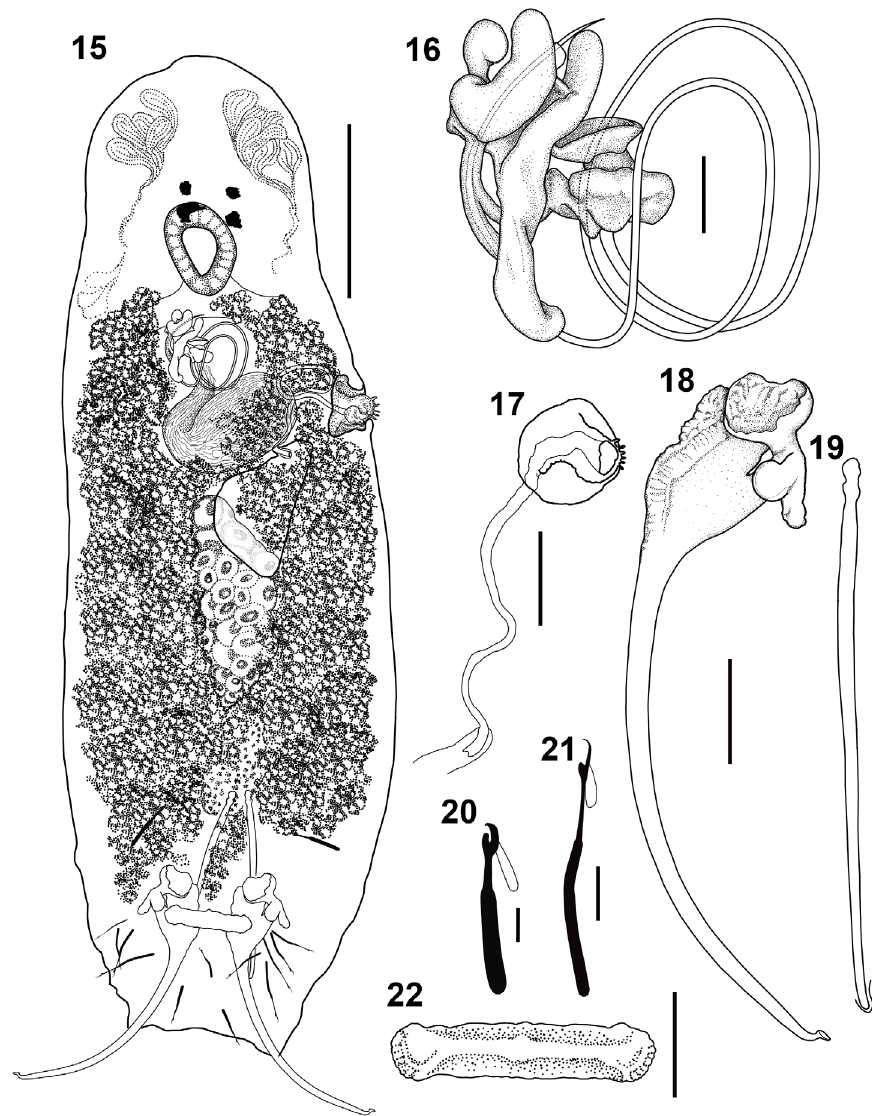
sclerotized, with 5-6 cuticular spine-shaped processes, short sclerotized vaginal canal (Figs.